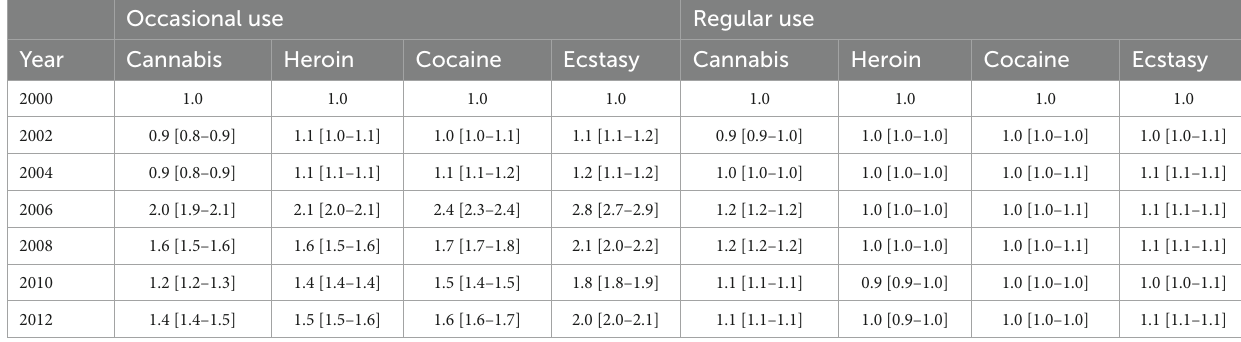
TABLE 3 Adjusted-prevalence ratio of high-risk perception 1 of drug use by specific drug use behavior and calendar-year [95% confidence intervals] among secondary students aged 14–18 years (Spain, 2000–2012). Occasional use Regular